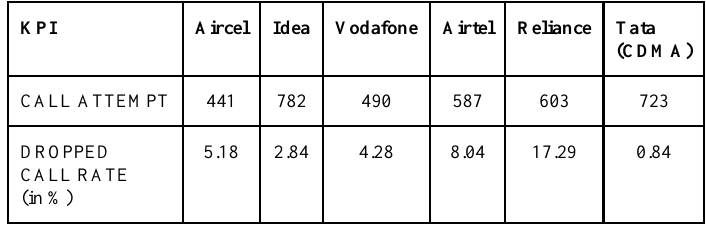
Table 2. Results of drive tests conducted by TRAI in Delhi in July, 2015 Results of Drive Tests at Mumbai by TRAI in June, 2015 as per Table 3. KPI